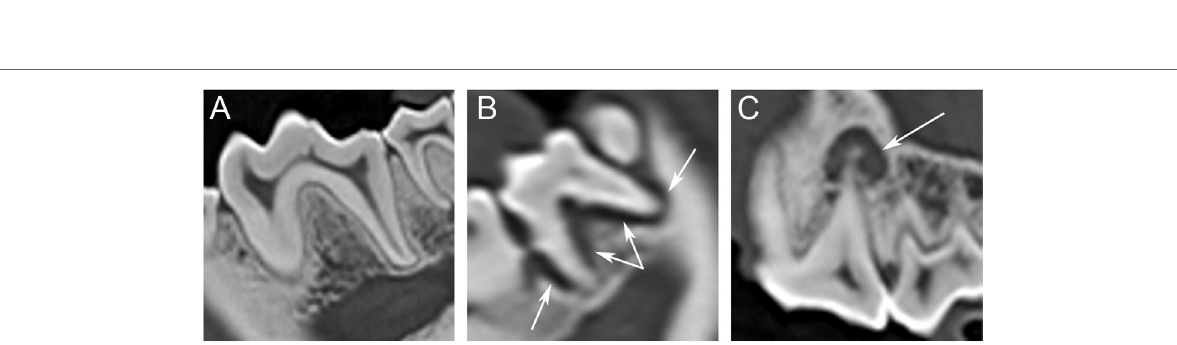
FigUre 1 | intraoral radiography: (a) periodontitis and endodontic disease absent in a 4-year-old male-castrated labrador retriever in tooth 309 (*) and 310 (^), (B) periodontitis present in a 14-year-old male Dachshund in tooth 309 (*) and 310 (^), and (c) endodontic disease present in a 4-year-old male-castrated labrador retriever in tooth 208 (**) .